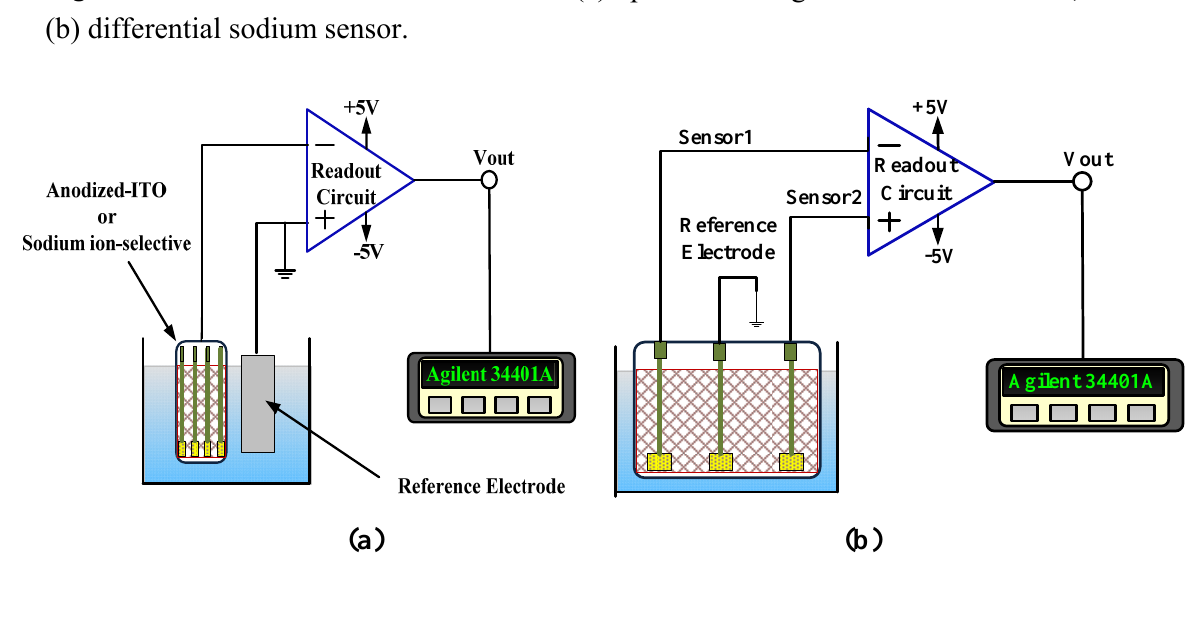
Figure 4. Measurement structures of (a) pH and single sodium electrode, and (b) differential sodium